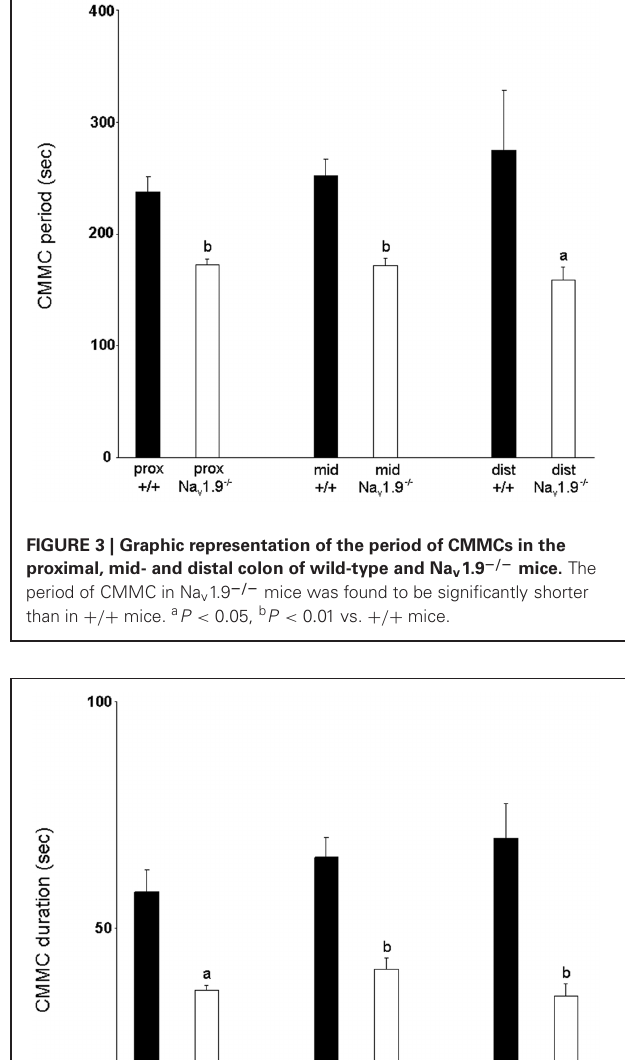
The mean area of CMMCs was 35977 ± 7366 mg.sec in the proximal colon, 44501 ± 3983 mg.sec in the mid- and 70320 ± 11761 mg.sec in the distal colon ( Figure 5 ). The area of CMMCs in the proximal colon was significantly smaller than in the dis- tal colon ( P < 0 . 05). We also found that the area of CMMCs was significantly larger in every region in Na v 1.9 − / − colons when compared to the corresponding regions from + / + mice ( P < 0 .